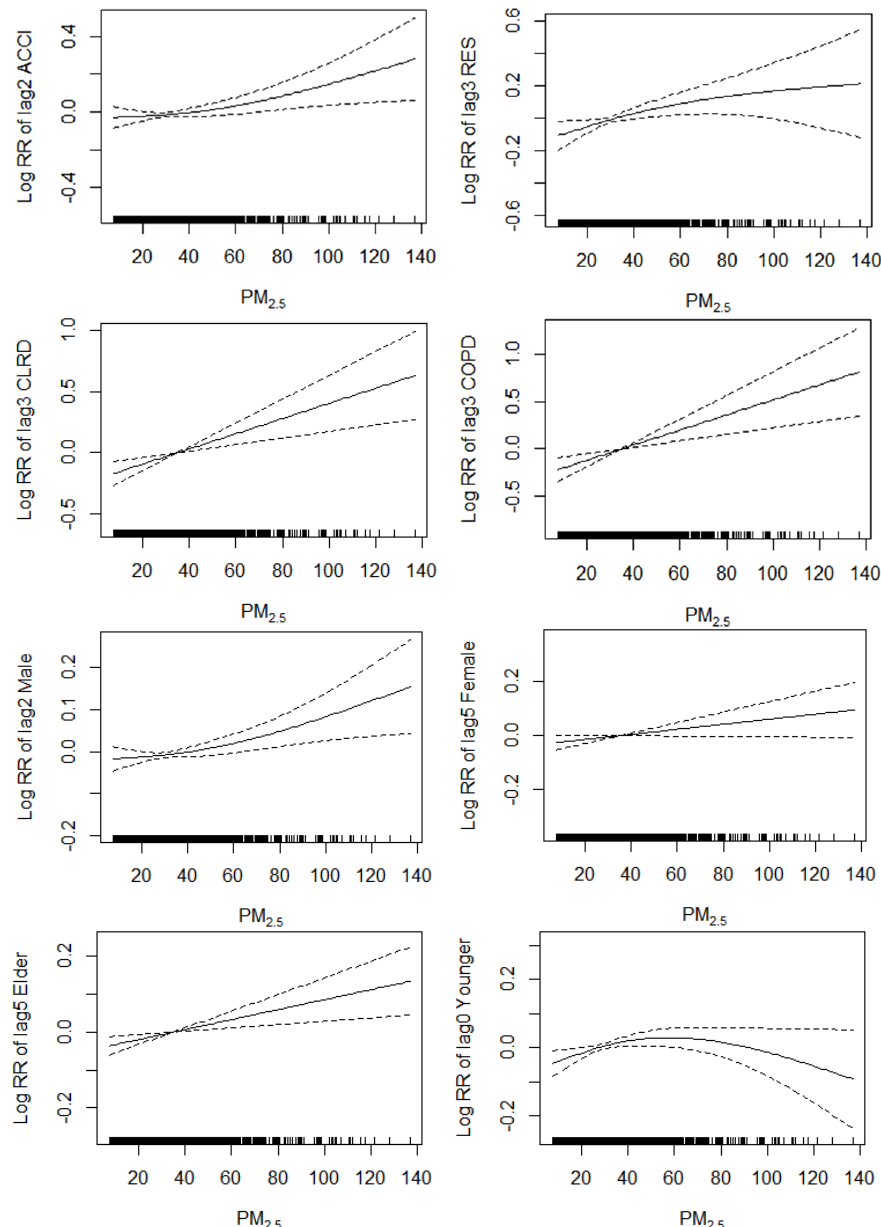
Figure 4. Association between the strongest effect among each single-day lag (lag0 –lag5) of residents’ mortality and PM 2.5 concentration (µg/m 3 ) considered in the generalized additive model. The solid line stands for fitting curve and intermittent lines stand for their 95% CI. RR is relative risk; Non-ACCI = non-accidental mortality; ACCI = accidental mortality; RES = total respiratory disease mortality; CLRD = chronic lower respiratory disease; COPD = chronic obstructive pulmonary disease; Elder = age is greater than or equal to 65 years old; Younger = age is less than 65 years old.